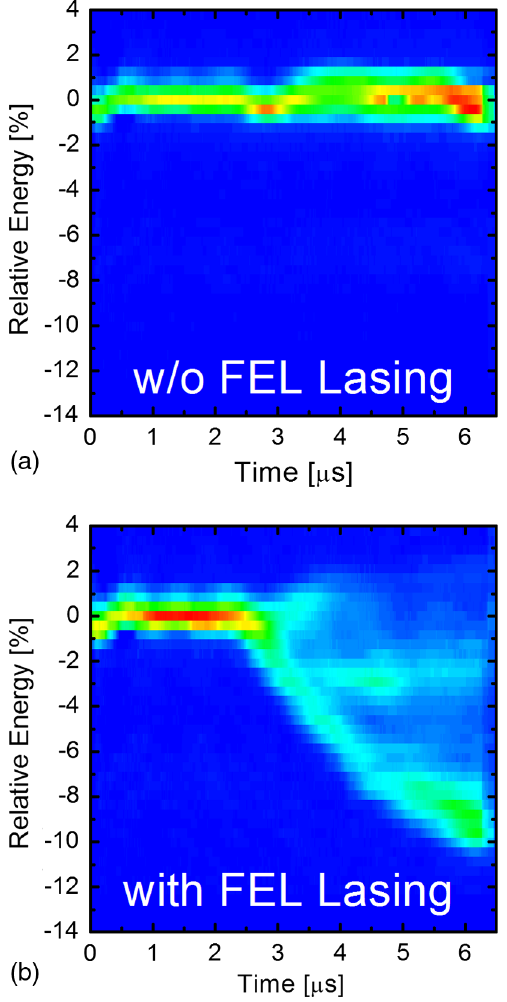
FIG. 7. (a) Evolution of the average energy and (b) evolution of the average energy loss calculated from the measured energy distributions with a DCD parameter of 9 . 4 μ